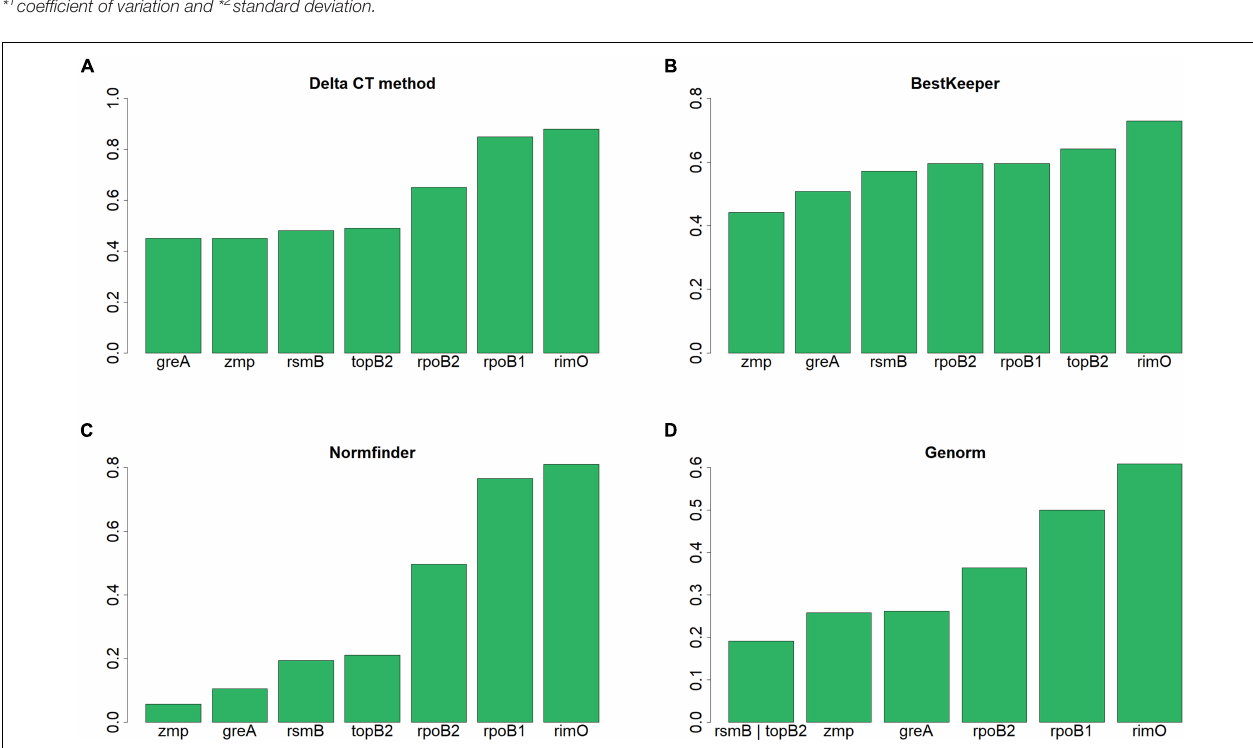
FIGURE 2 | Expression stability of candidate reference genes in C. beijerinckii NRRL B-598 assessed by RefFinder tools. (A) Delta CT method, (B) BestKeeper, (C) Normfinder, and (D) Genorm.